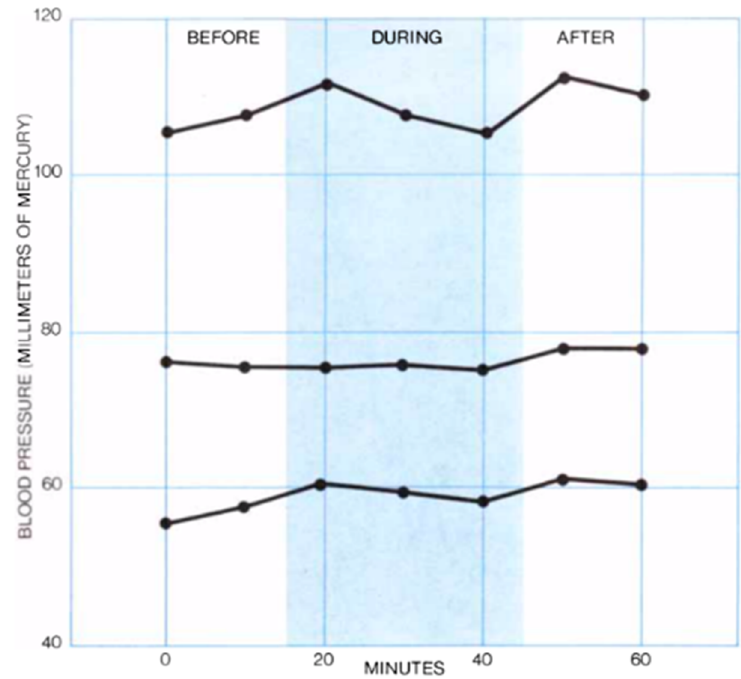
Figure 3. Blood pressure changes during meditation.